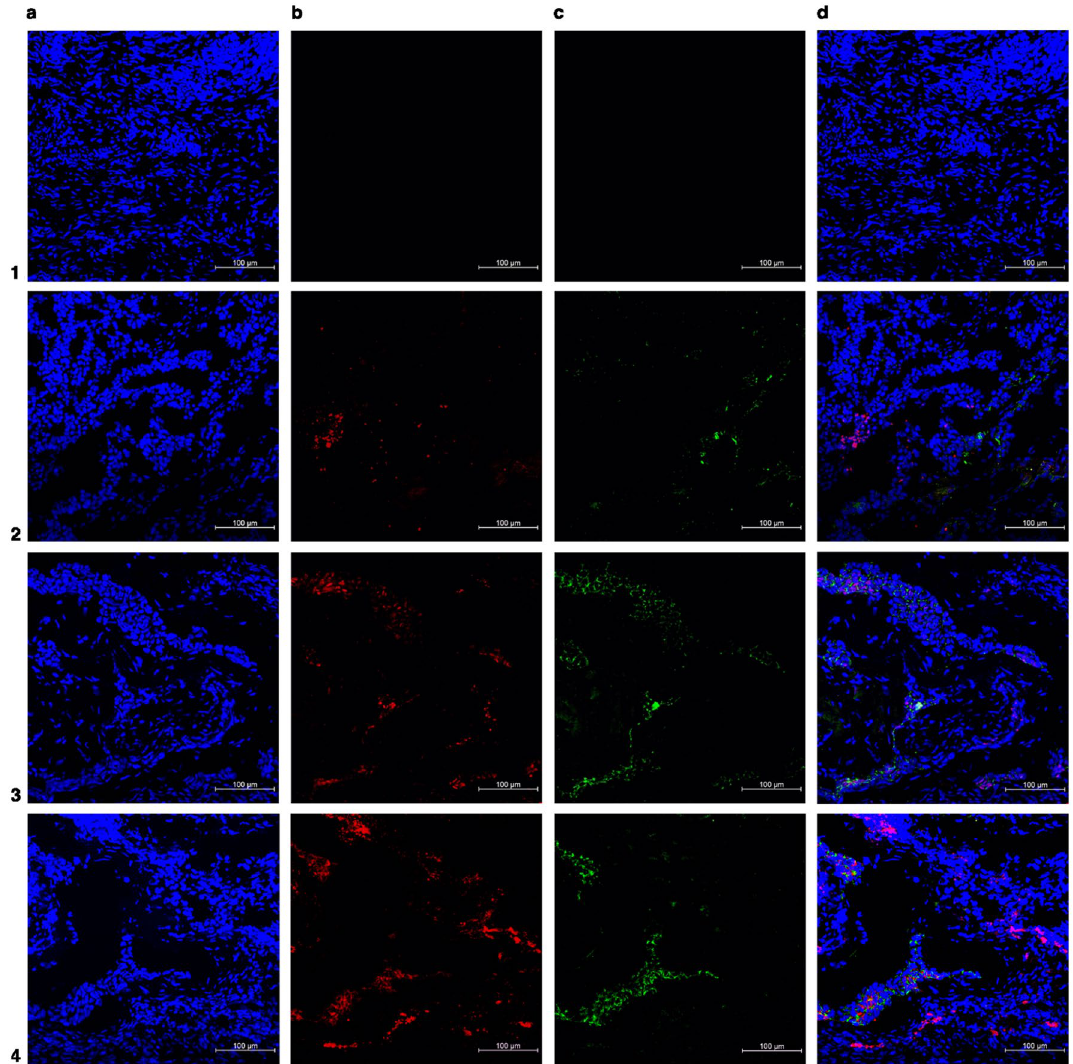
Figure 2. Representative immunofluorescence costained images of ovarian endometrioma. ( a ) In blue: DAPI ( b ) in red: senescent associated biomarkers (p16 or lamin b1) ( c ) in green: anti-E-cadherin antibody (epithelial glandular cells) ( d ) merged. Number 1 row represents negative control (endometrioma), number 2 row represents positive control (endometrial cancer or random ovary), number 3 row represents endometrioma labeled with p16, and number 4 row represents endometrioma labeled with lamin b1. ×20